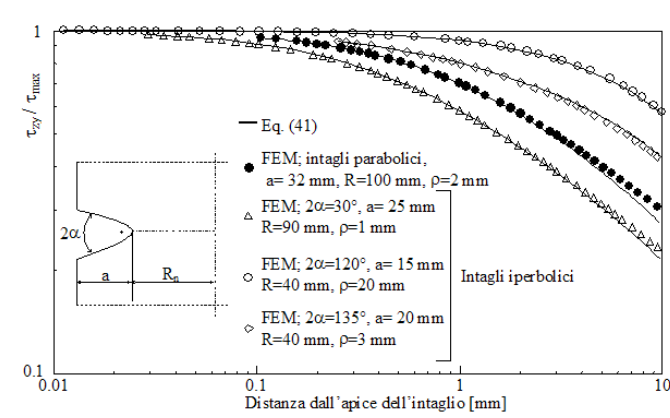
τ lungo la bisettrice dell’intaglio normalizzate Figura 11: Componenti di tensione zy rispetto alla tensione massima (intagli iperbolici e